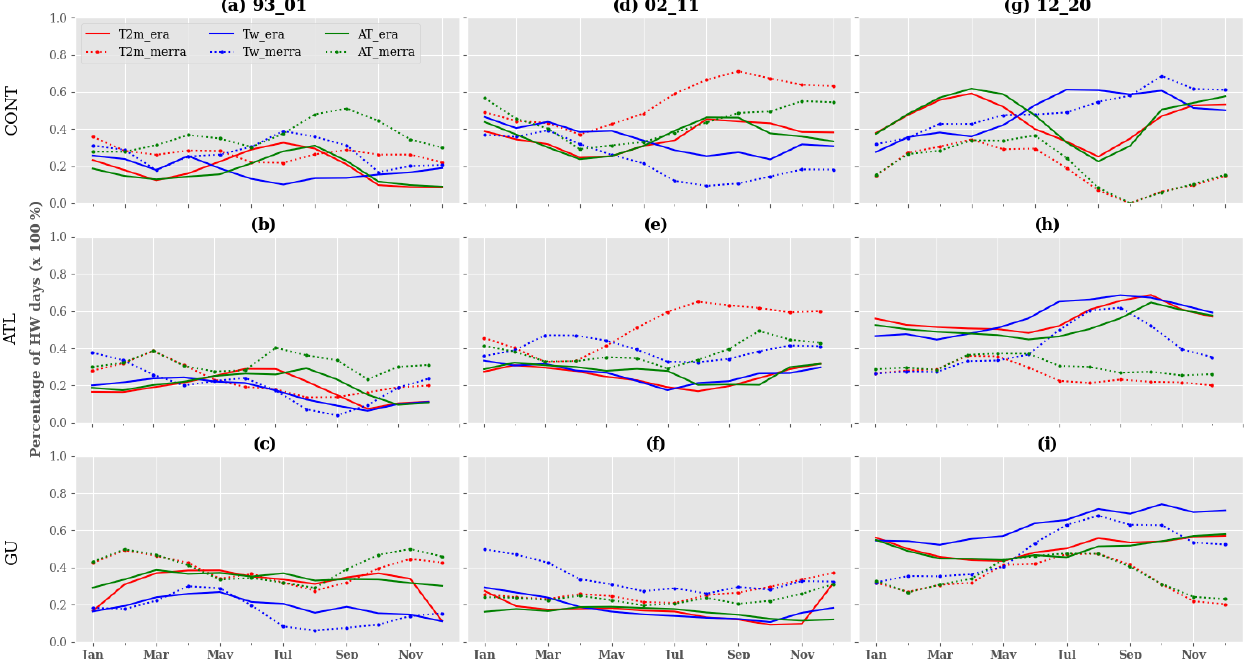
Figure 9. Contribution in percent of the different decades to heat wave duration using maximum values of T 2m , T w and AT over the whole period for (a–c) 1993–2001, (d–f) 2002–2011 and (g–i) 2012–2020. We compute a 3-month running mean to smooth the seasonal cycle. The detection of heat waves is done using the 90th percentile as a threshold over the period in the different regions: (a, d, g) CONT, (b, e, h) ATL and (c, f, i) GU. The solid and dashed red/blue/green lines represent the evolution of heat wave duration using T 2m / T w /AT from ERA5 and MERRA respectively. The y and x axes represent the percentage of heat wave days and the time in months